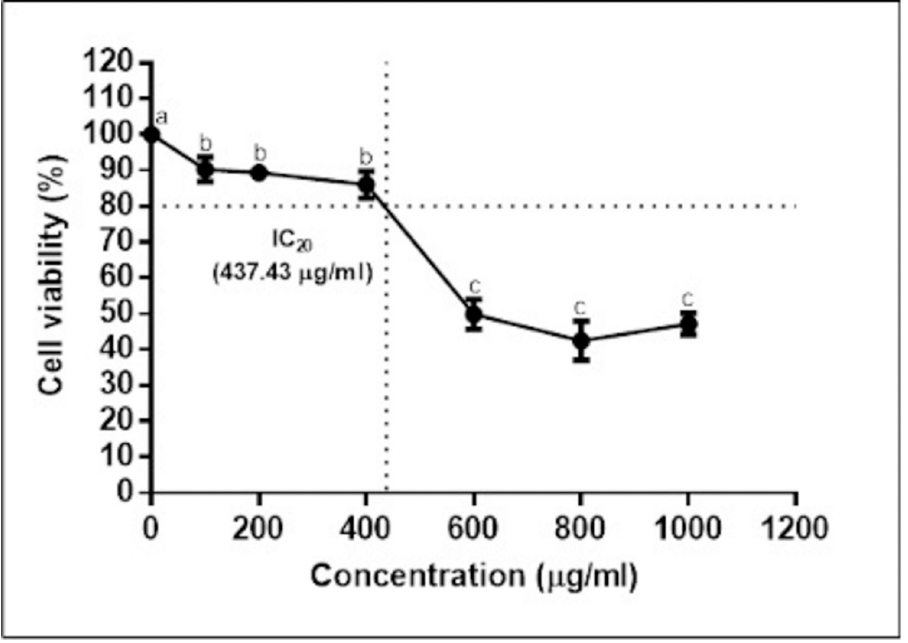
Fig 3. Effects of different concentrations of MOL on the cell viability (%) of hWJ-MSCs after 48 h. The results were reported as mean ± SD. Significant difference (p < 0.05) among treatments were represented by different superscripts.